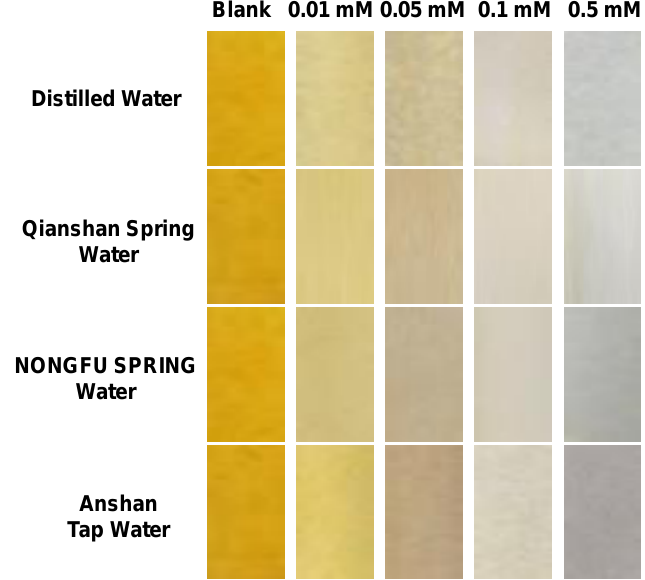
Figure 9. Color responses of L-ol -coated chromatography plates towards different concentrations of HOCl (0–0.5 mM) in several natural water samples.